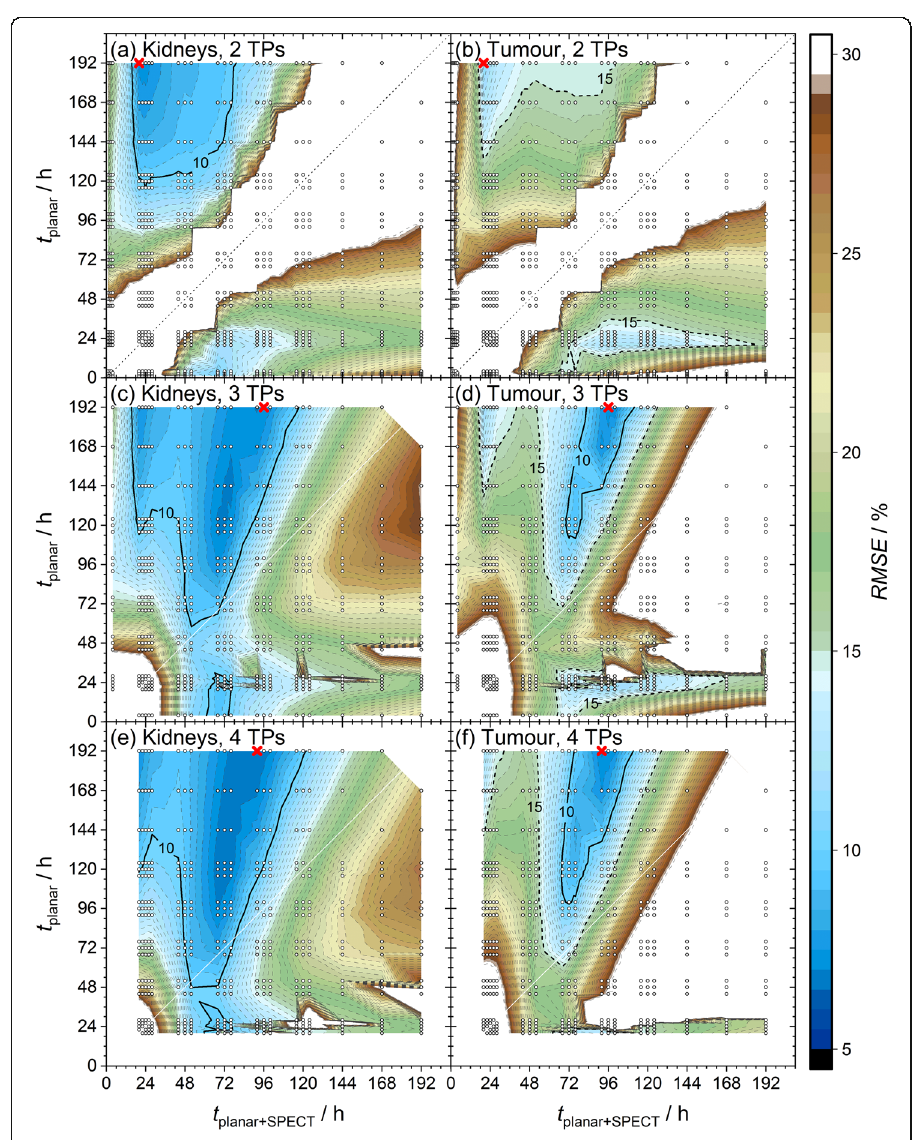
Fig. 3 Effect of varying the last two time points (time point of the planar image followed by the SPECT/CT: t planar+SPECT ) from the optimal schedules for the hybrid planar/SPECT method (Table 1) on the root-mean- square error (RMSE) values of the kidneys and the tumours. The optimal schedules and the investigated alternatives of the last two time points are marked with red crosses and white circles, respectively. Contour lines with RMSE = 10 % for the kidneys (black line) and with RMSE = 10%, 15% (black dashed line) for the tumours are highlighted. The results base on the simulations using a fraction of systematic error to the total error of f syst =